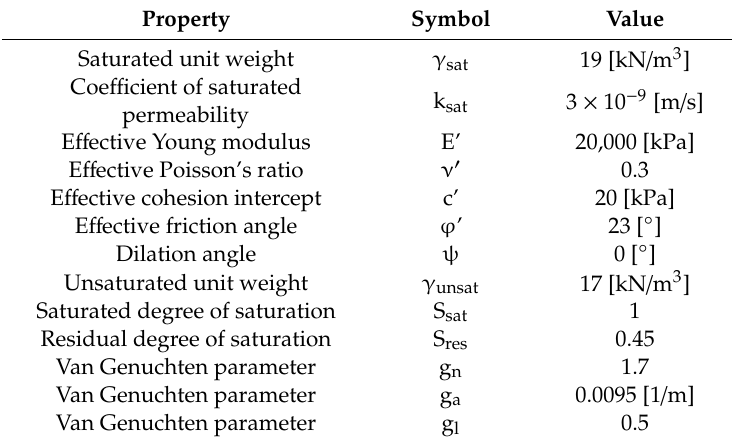
Table 1. Hydromechanical parameters characterizing the model